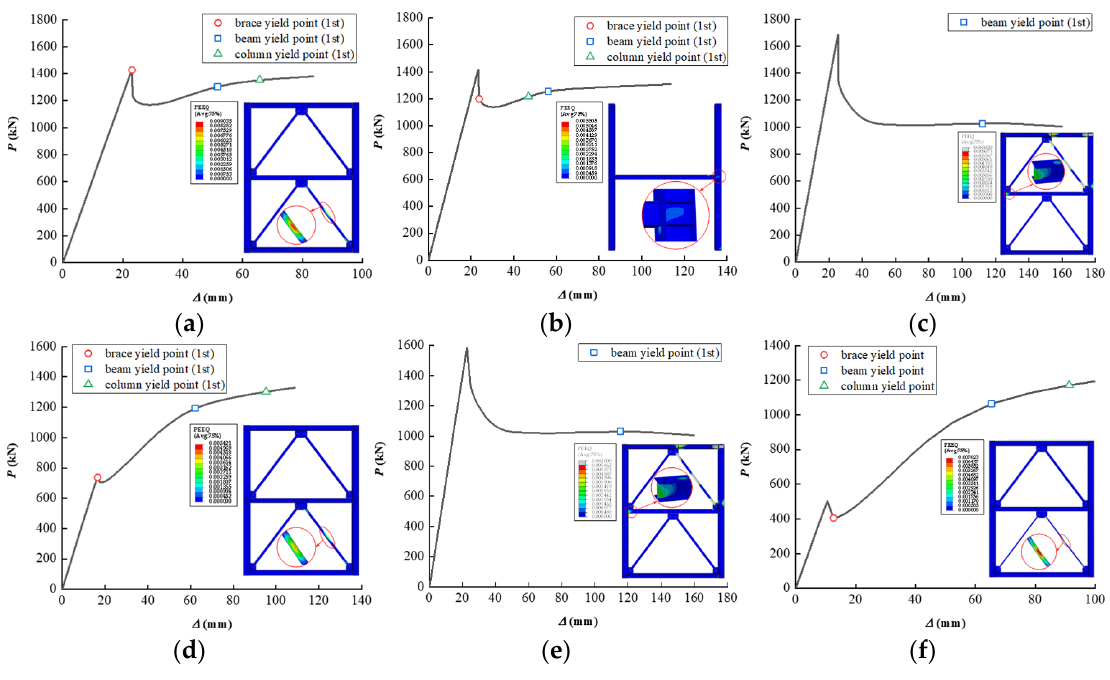
Figure A4. The predicted PEEQ distributions of a typical floor with η = 0.15. ( a ) case 31, the basic model obtained by the proposed method; ( b ) case 34, decreasing the section area of the column web; ( c ) case 37, thicker braces; ( d ) case 40, thinner braces; ( e ) case 43, larger brace external diameter; ( f ) case 46, smaller brace external diameter.